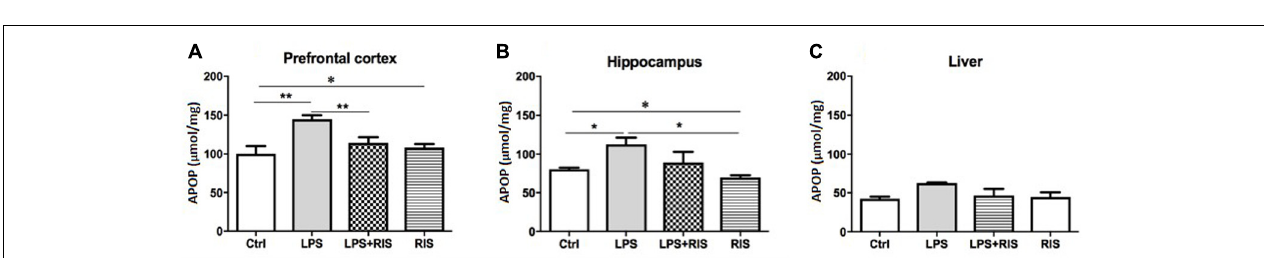
FIGURE 2 | Effect of various treatments on the level of advanced protein oxidation products (APOPs). Groups are Ctrl (control), LPS (lipopolysaccharide), LPS+RIS (lipopolysaccharide + risperidone), and RIS (risperidone). The level of AOPP was determined from the prefrontal cortex (A) , hippocampus (B) , and liver (C) tissues. Values are represented as mean ± SEM. Post hoc multiple comparison test namely, “Newman–Keuls” test was used to compare between groups. n = 6 per group. ∗ p < 0.05, ∗∗ p < 0.01, ∗∗∗ p < 0.001.